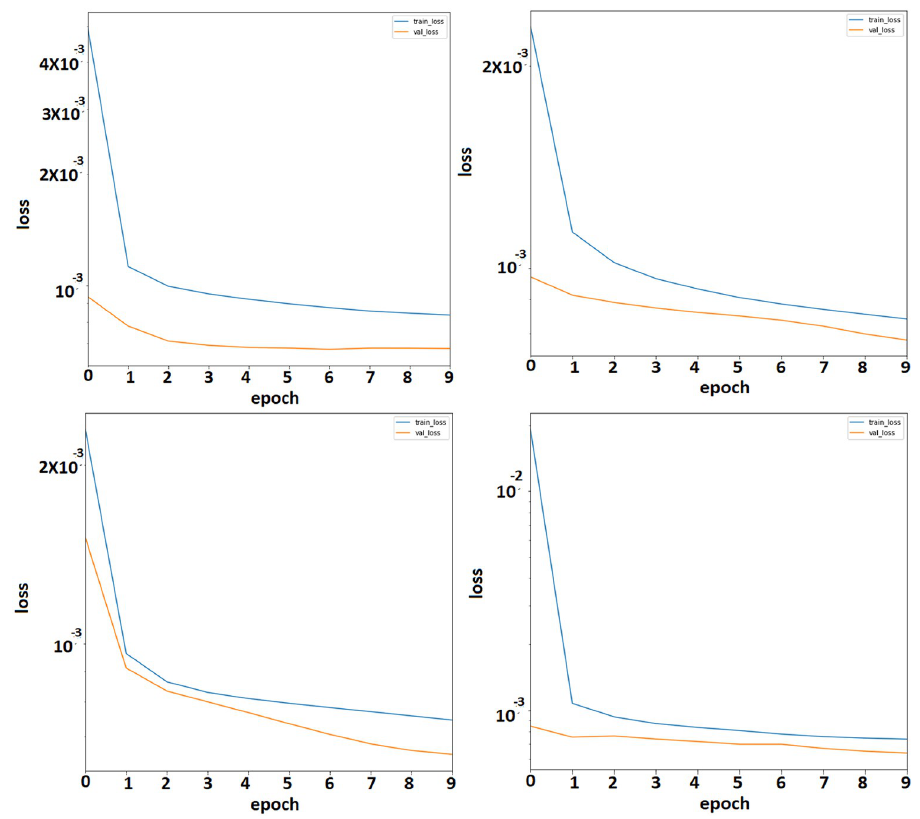
Fig 7. Hourly loss plot between training and evaluation by including the number of crime types in ES-BiLSTM.